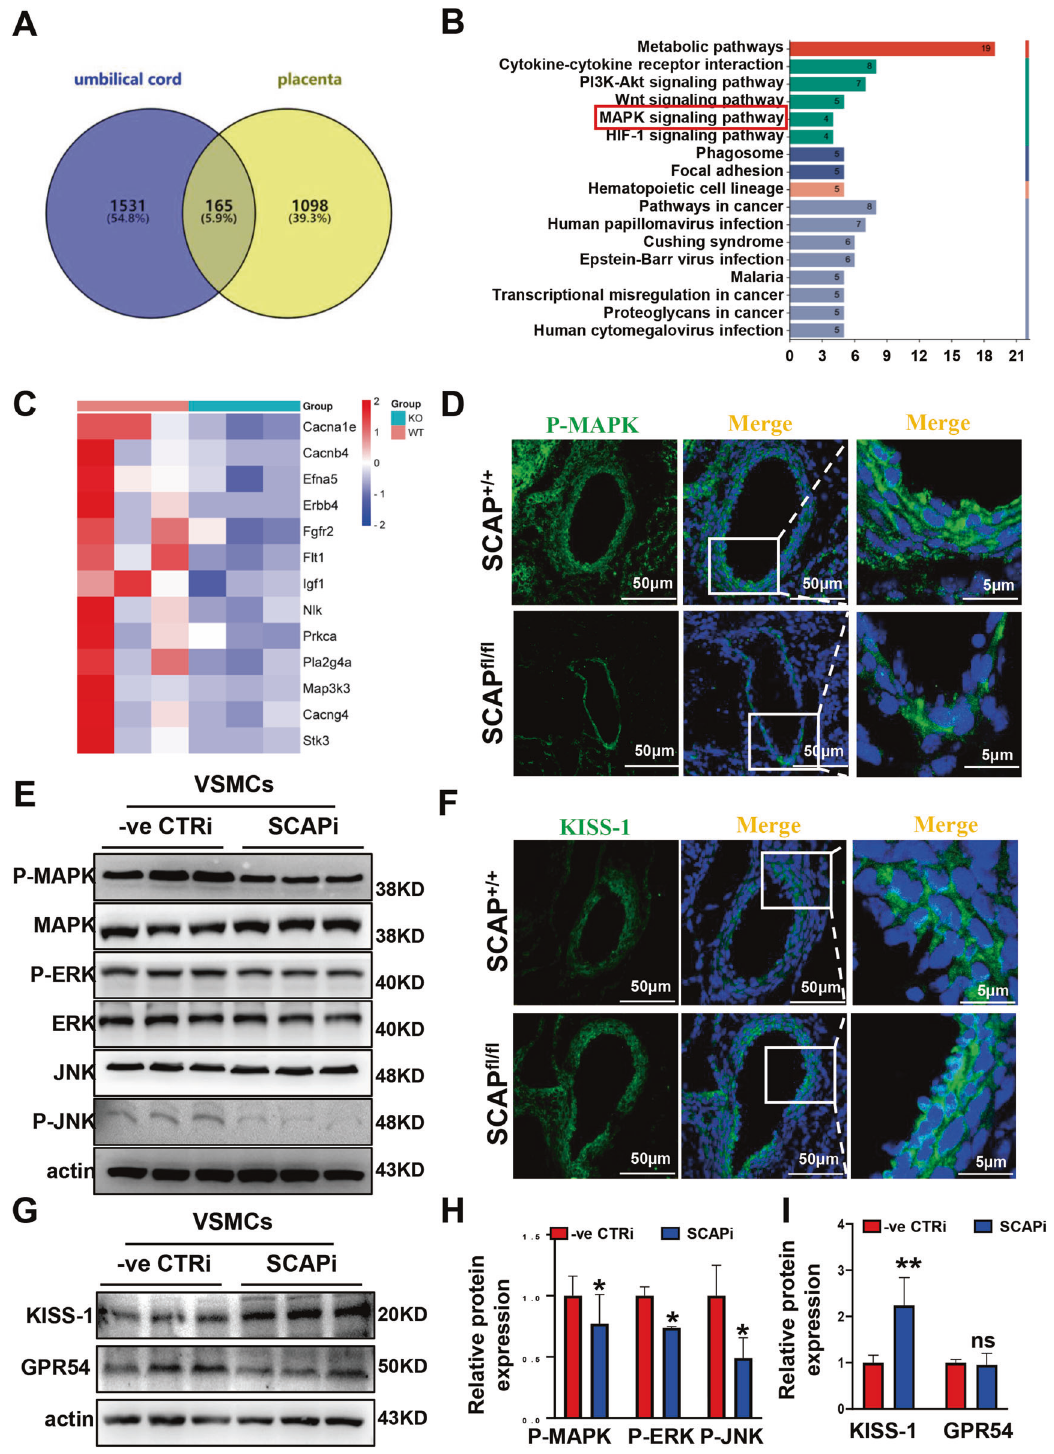
Fig. 4 Ablation of SCAP in VSMCs increases the expression of KISS-1 in mouse embryos. A Venn diagram of the differentially expressed genes (DEGs) in the umbilical cord and placenta from SCAP + / + and SCAP fl / fl mice. B KEGG enrichment analysis of the 165 DEGs screened from ( A ). C Heatmap of the related molecules in the MAPK signaling pathway from SCAP + / + and SCAP fl / fl mice. D Immuno fl uorescence staining of P-MAPK in the embryonic aorta at E14.5 ( n = 6). Scale bar = 50 μ m. Enlarged merge views of the red boxes are shown. Scale bar = 5 μ m. E Western blot analysis and quanti fi cation of MAPK, P-MAPK, ERK, P-ERK, JNK and P-JNK protein expression in CTRi and SCAPi VSMCs. F Immuno fl uorescence staining of KISS-1 in the embryonic aorta at E14.5 ( n = 6). Scale bar = 50 μ m. Enlarged merge views of the red boxes are shown. Scale bar = 5 μ m. G Immunoblot analysis of KISS-1 and GPR54 protein expression in CTRi and SCAPi VSMCs. H Statistical analysis of the relative protein expression levels in ( E ). I Statistical analysis of the relative protein expression levels in ( G ). Data are presented as the mean ± SD. * P < 0.05, ** P < 0.01, *** P < 0.001. P values were calculated by Student ’ s t test.